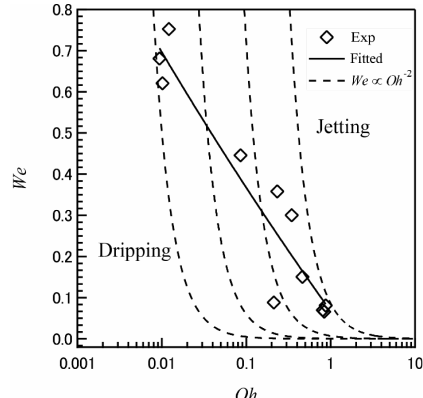
Figure 2. Observed capillary jet in a Centrifuge-Based Droplet Shooting Device (CDSD): ( a ) Dripping regime; ( b ) Jetting regime. The insets depict schematic images of the dripping ( a ), and jetting ( b ), observed. The scale bars are 200 μm.